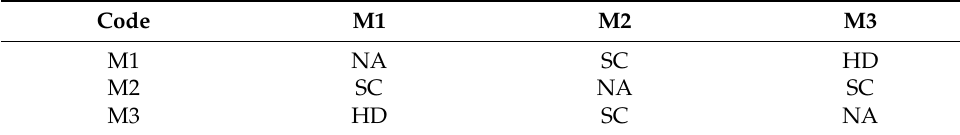
Figure 2. Isometric view of drill holes by mineral zone code. Table 2. Contact analysis of Au (ppm) by mineral